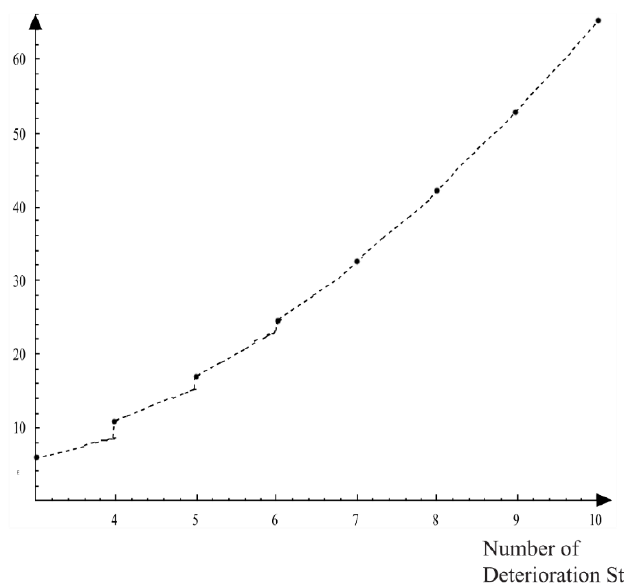
Figure 4. Variance of failure time in the two-unit parallel redundant system with deterioration on 𝑛 × 𝑛